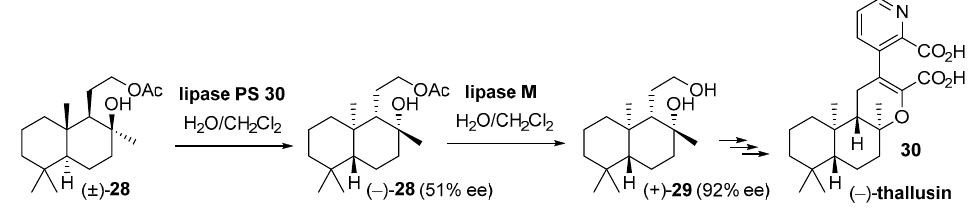
measured for the acetylation of alcohol 22 .